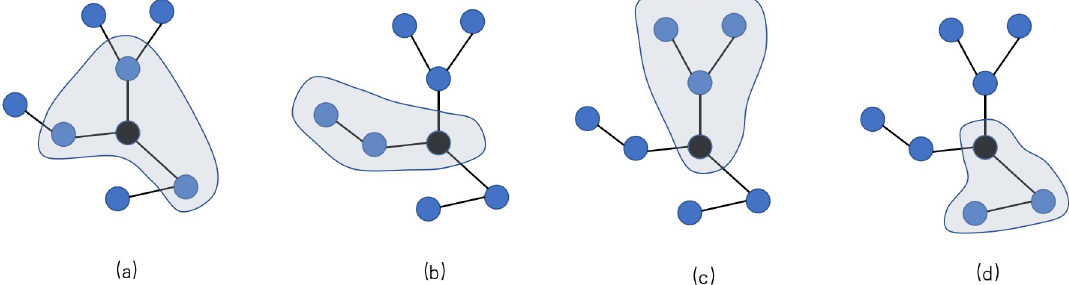
Fig 1. An example of public goods game on the network. We show 8 structured populations, where each node is connected to other nodes. Each player participates in a public goods game centered on him and his neighbors. For example, the black nodes in the graph participated in four public goods games: one centered on itself (a), and the other three centered on its three neighbors (b)-(d). The payoff of the central node comes from four public goods games. Payoff for the other players is calculated in the same way.